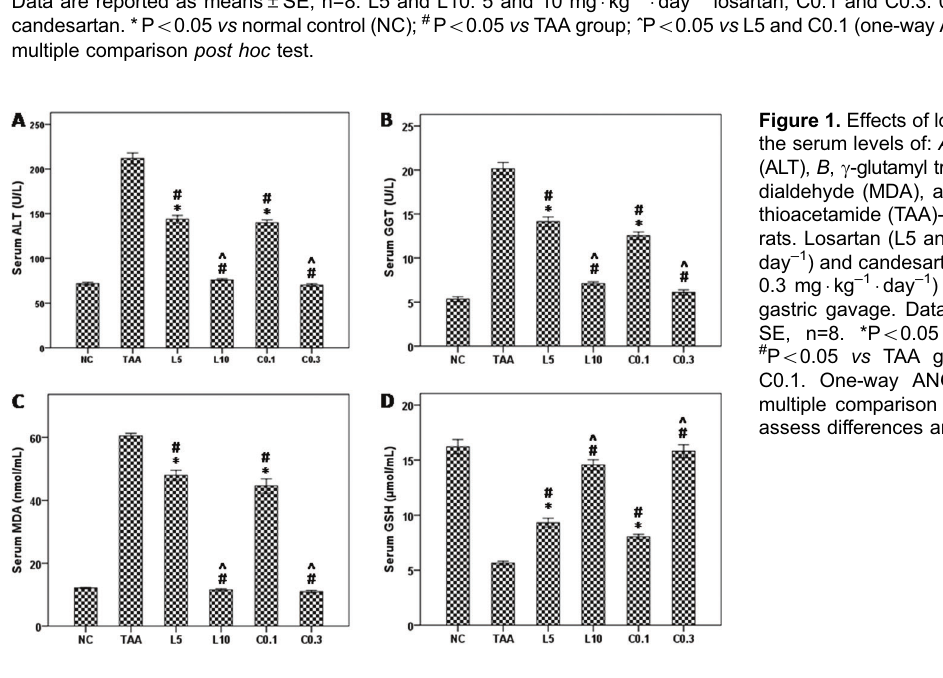
Data are reported as means ± SE, n=8. L5 and L10: 5 and 10 mg (cid:1) kg – 1 (cid:1) day – 1 losartan; C0.1 and C0.3: 0.1 and 0.3 mg (cid:1) kg – 1 (cid:1) day – 1 candesartan. *P o 0.05 vs normal control (NC); # P o 0.05 vs TAA group; ̂ P o 0.05 vs L5 and C0.1 (one-way ANOVA followed by Tukey ’ s multiple comparison post hoc